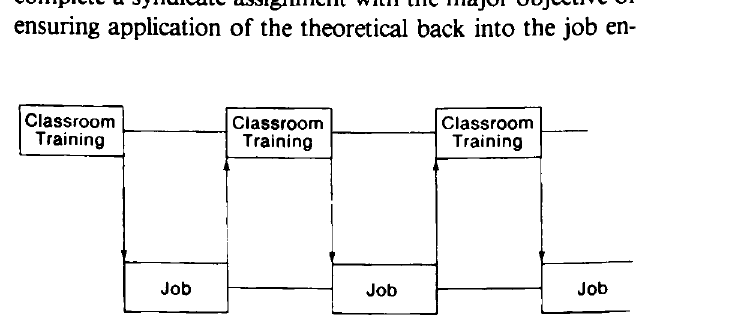
Figure 2 The interactive training